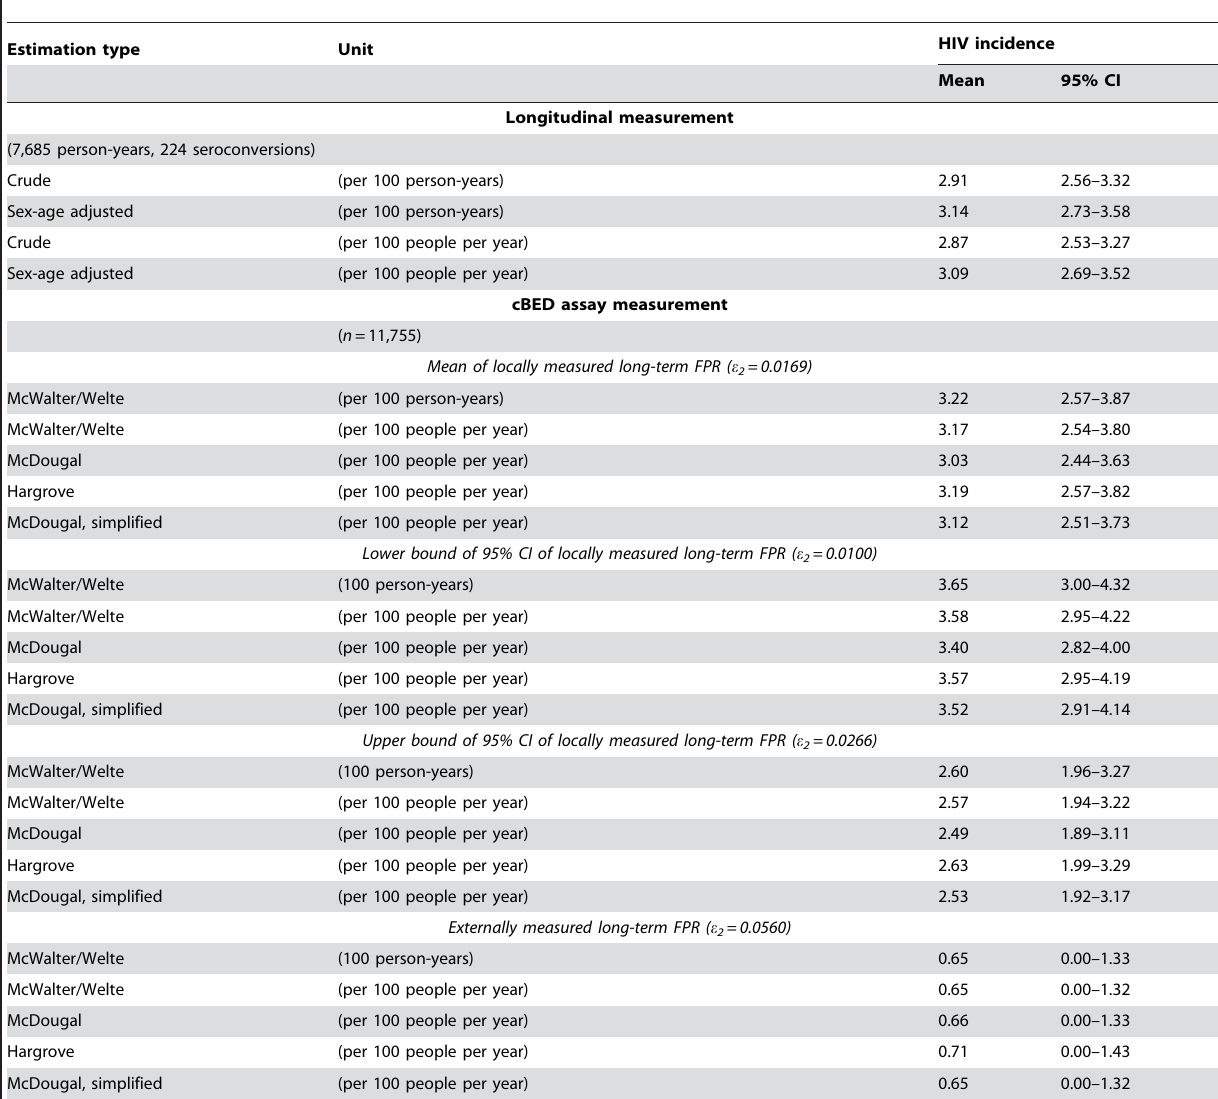
Table 2. HIV incidence